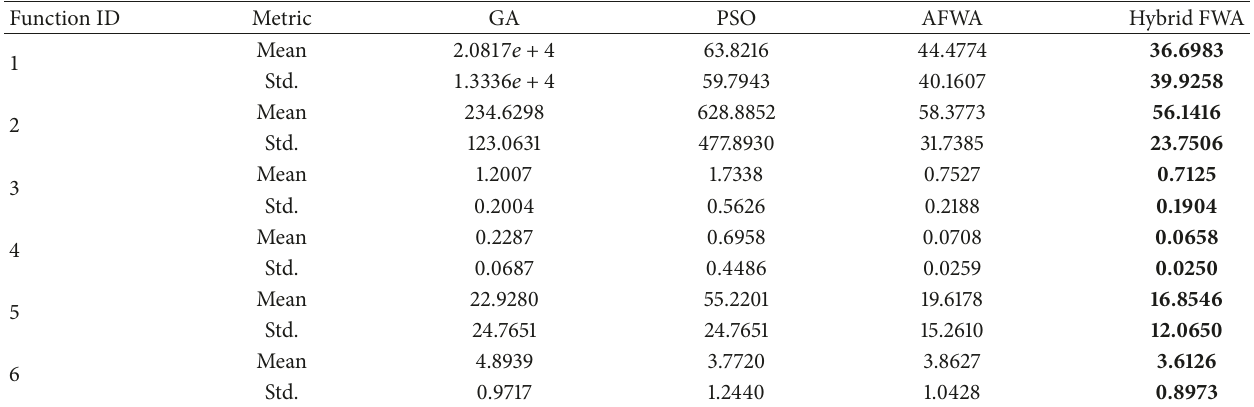
Table 3: Algorithm testing results.